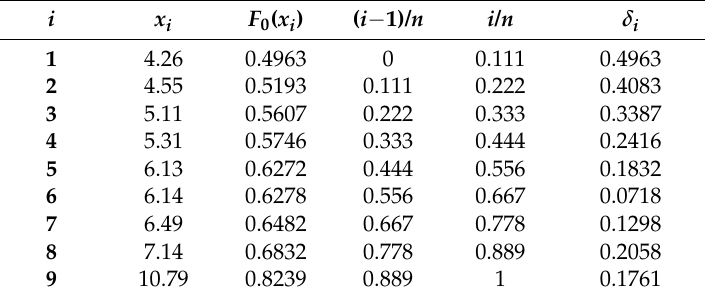
Table 6. KS test of Logarithmic distribution.